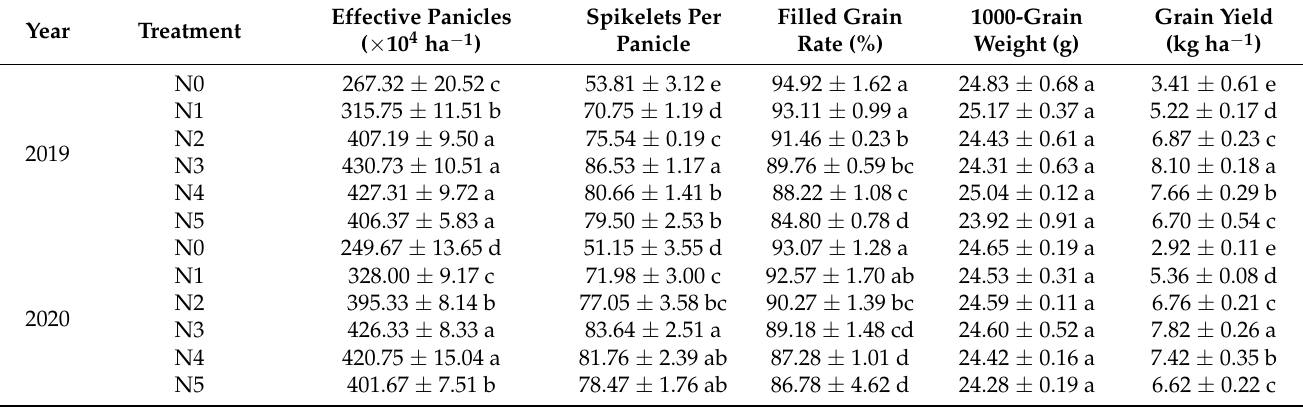
Table 11. Effect of N application rate on grain yield and yield composition of rice under dry cultivation